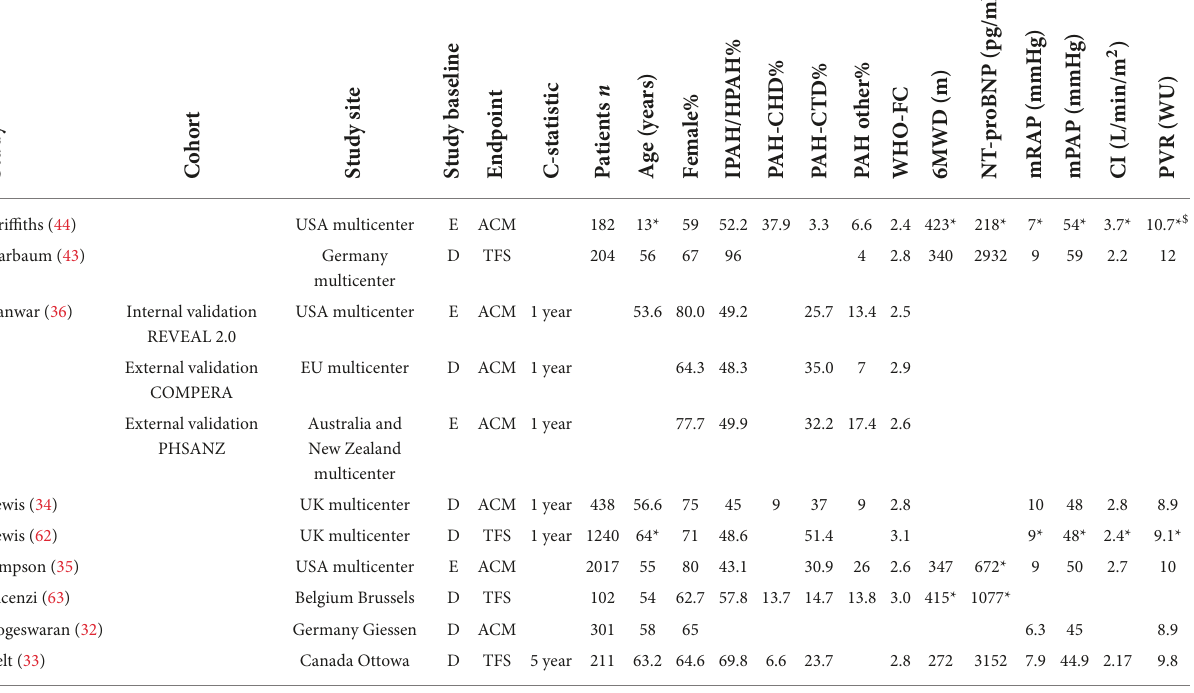
TABLE 3 Study characteristics of studies describing model enhancement.